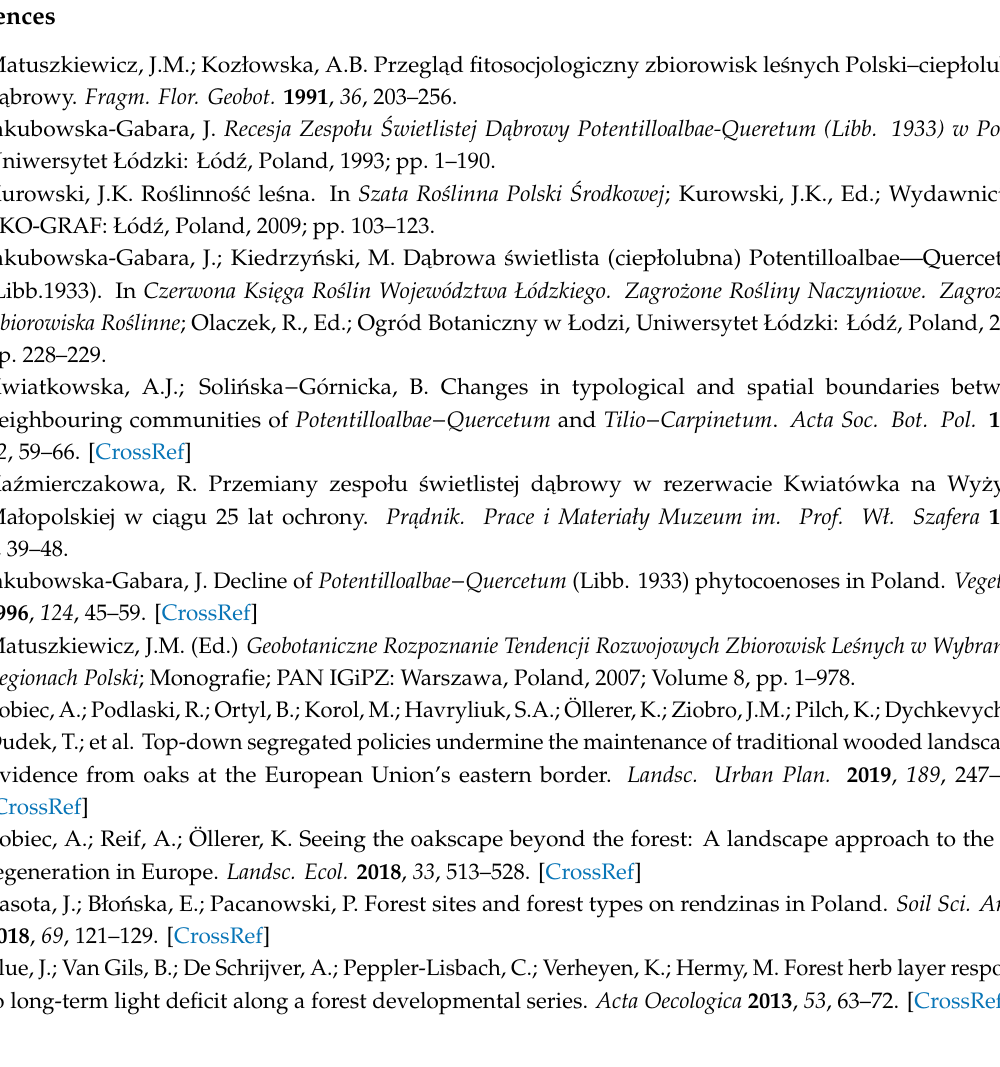
Table S1: Frequency (%) of the oak forest herb layer species before (2016) and after (2017) application of treatments, Table S2: Estimation of species cover in undergrowth of the oak forest in 2016 (prior to treatments) and 2017 (a year after